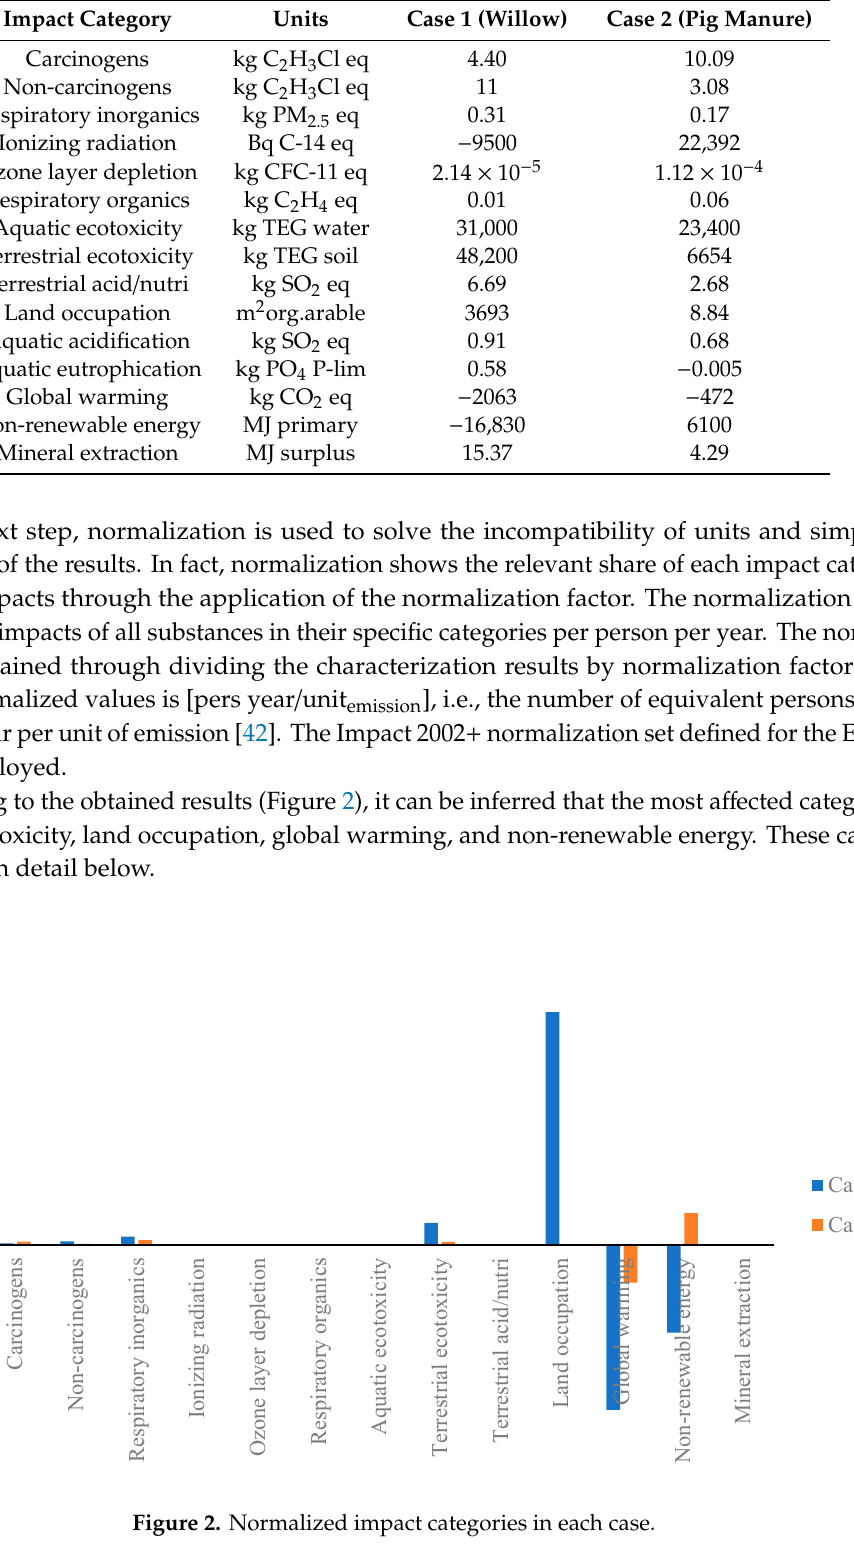
Table 4. IMPACT2002 + mid-point results (per ton of biochar).